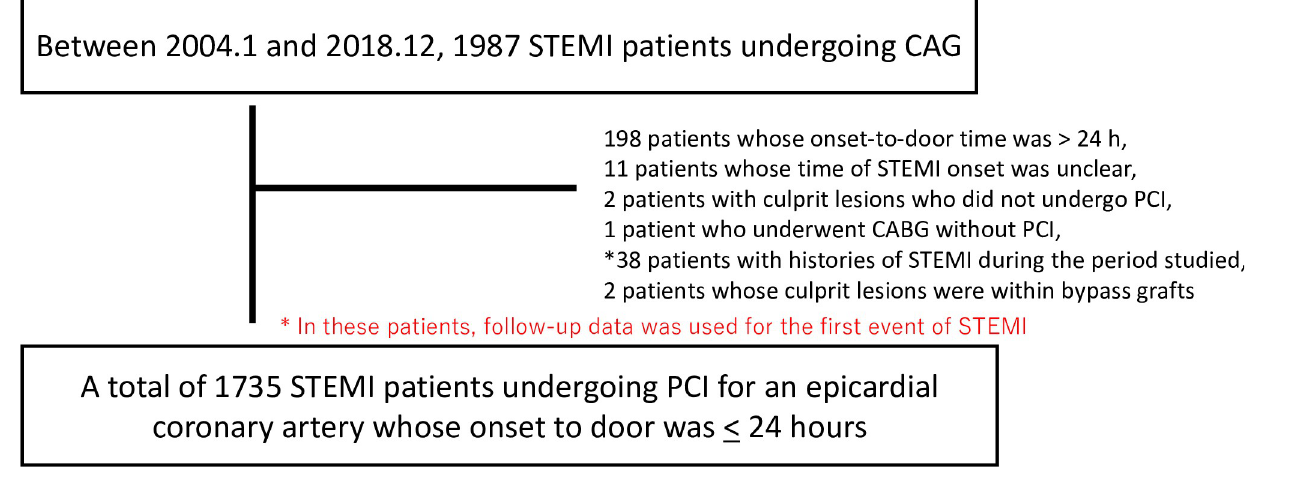
Fig 1. Study population all patients. STEMI, ST elevated myocardial infarction; CAG, coronary angiography; CABG, coronary artery bypass grafting.